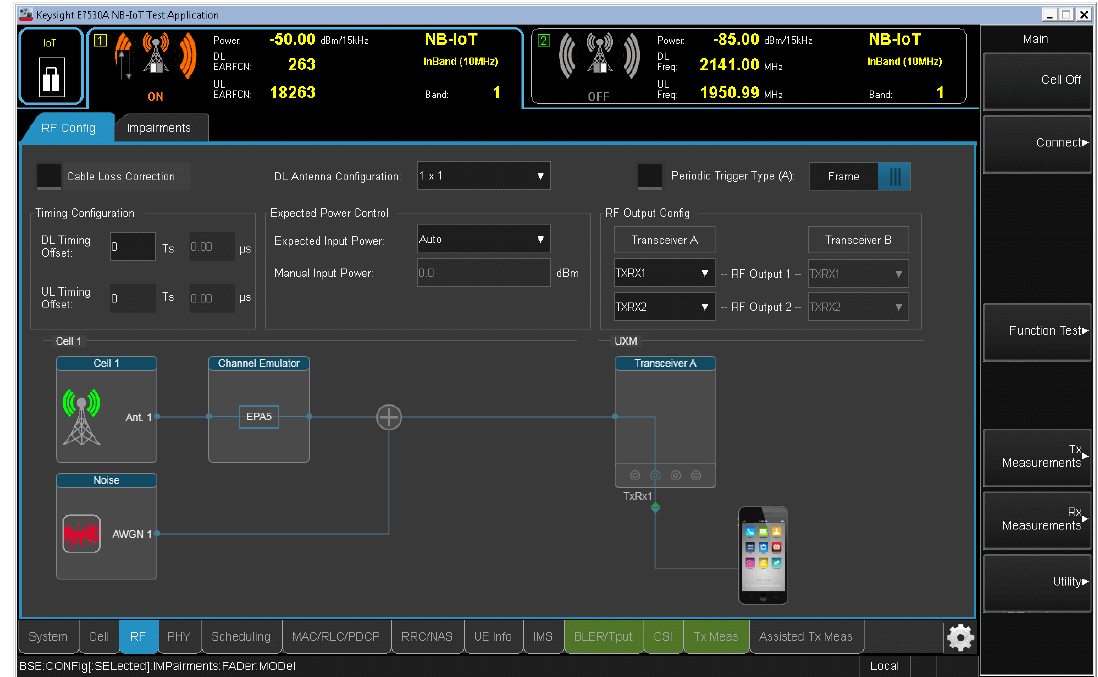
Figure 7. Radio propagation and interferences